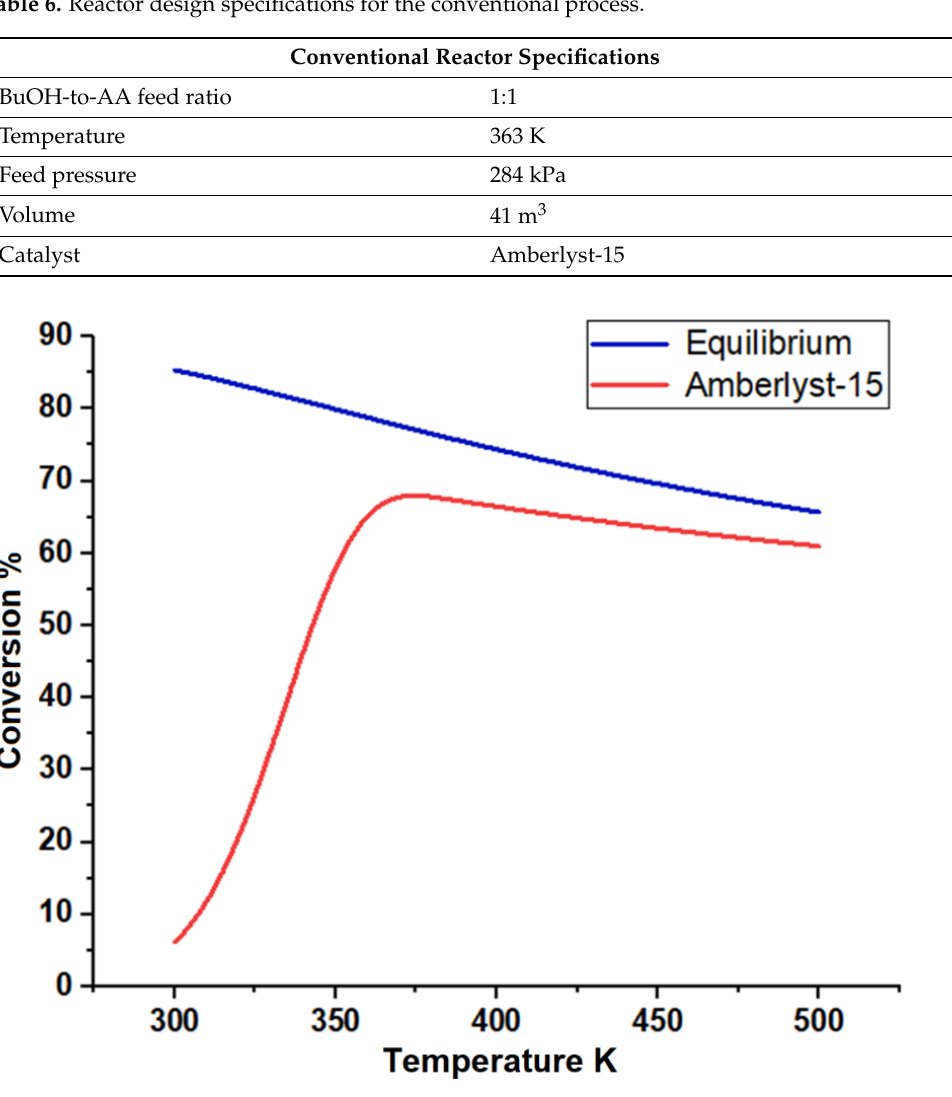
Figure 14. n -butanol conversion as a function of reactor length.